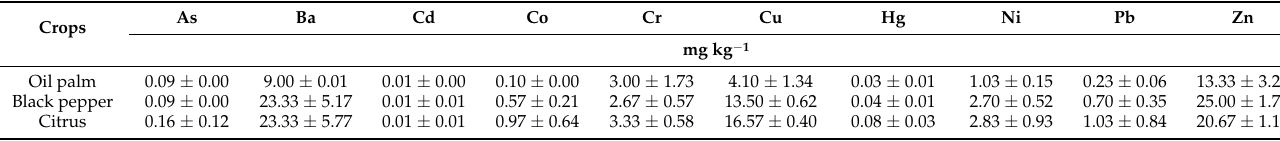
Table 3. Concentrations of potentially toxic elements in plant